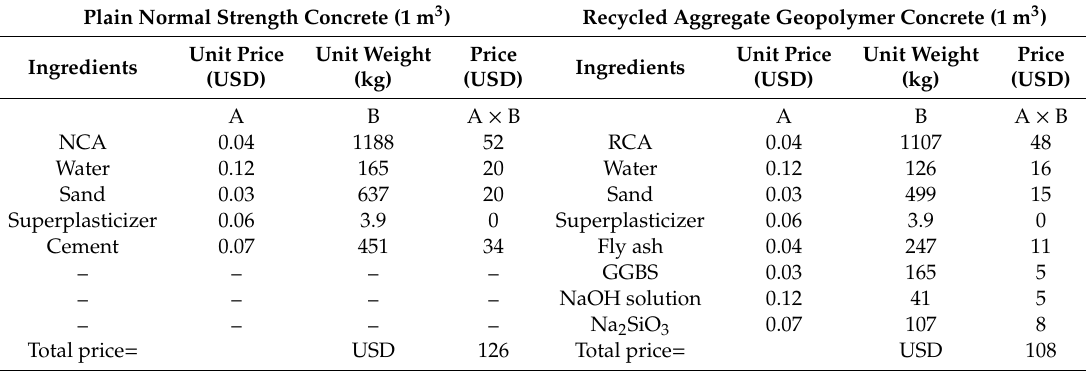
Table 6. Financial Comparative Analysis of PNSC and RAGC for 1 m Cube of Concrete.